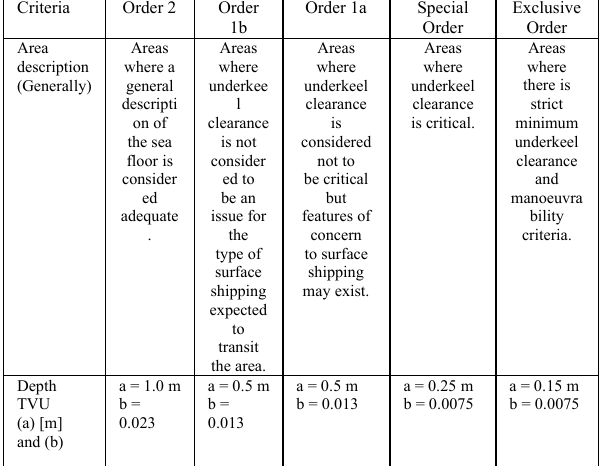
Table 2. Minimum bathymetry standard (International Hydrographic Organization Standards for Hydrographic